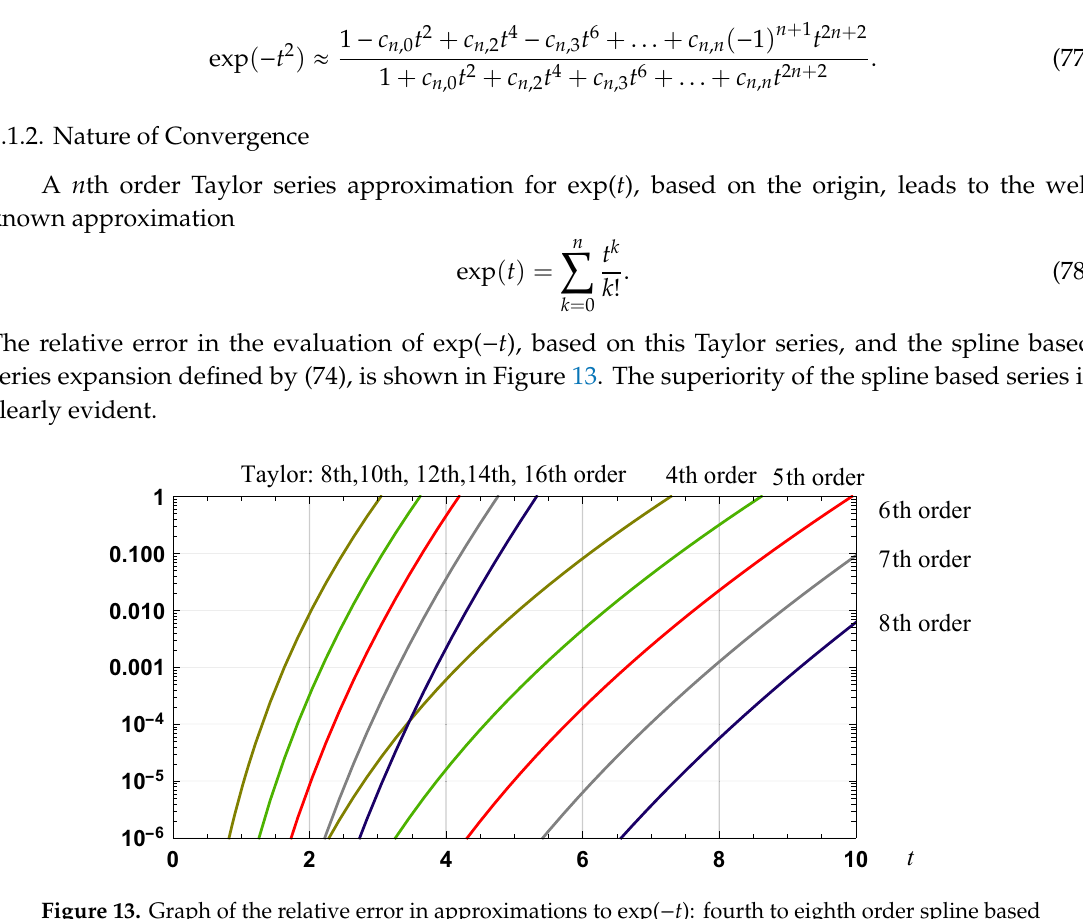
Figure 13. Graph of the relative error in approximations to exp( − t ): fourth to eighth order spline based approximations along with eighth to sixteen order Taylor series approximations.